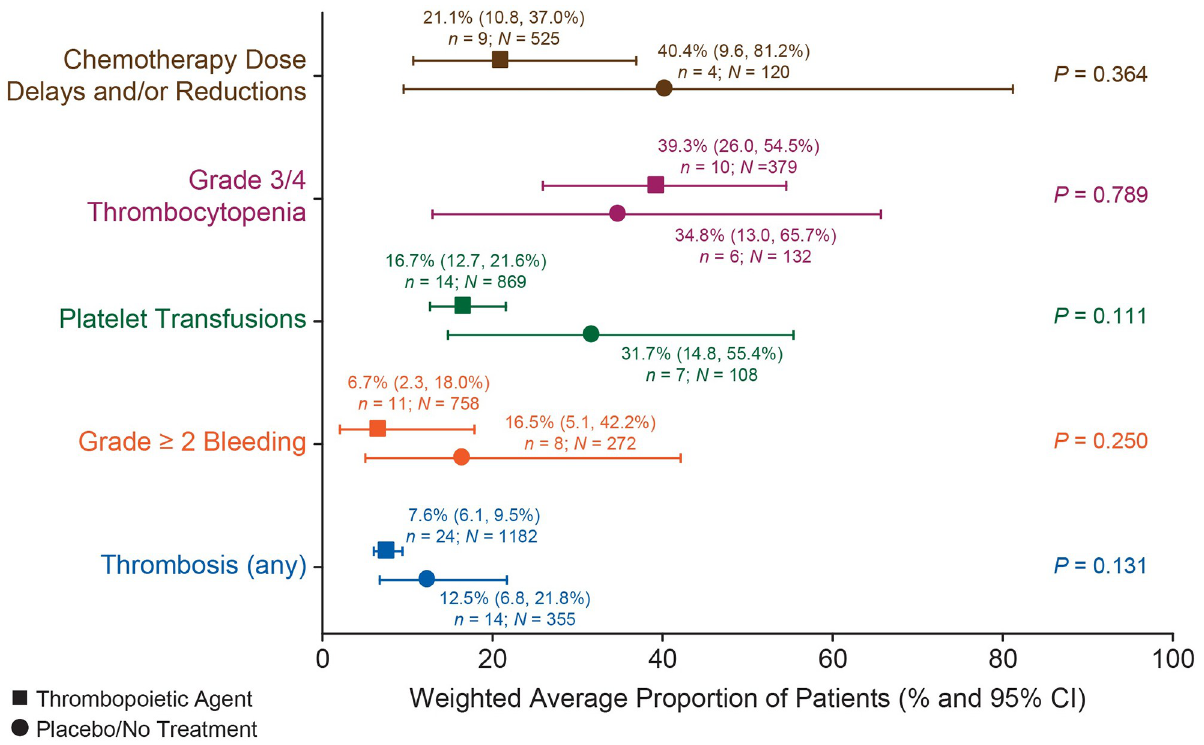
Fig 2. Meta-analyses of efficacy and safety outcomes. n = number of studies with a study arm reporting the endpoint of interest. N = total number of patients in study arms reporting the endpoint of interest. Meta-analyses were performed for efficacy and safety data from 30 studies that had outcomes data reported in � 3 studies for thrombopoietic agents versus control (comparator, placebo, or no treatment) for the prevention or treatment of CIT across all tumor types and summary proportions (point estimates) and 95% CIs (horizontal bars) of patients experiencing the outcome calculated. Heterogeneity was assessed using Cochran’s Q test and the I2 statistic, and individual study weights created using the inverse of their variance. n represents the number of studies with a study arm reporting the endpoint of interest. CI, confidence interval; CIT, chemotherapy-induced thrombocytopenia; I 2 , degree of heterogeneity; thrombopoietic agent, thrombopoietin receptor agonist.